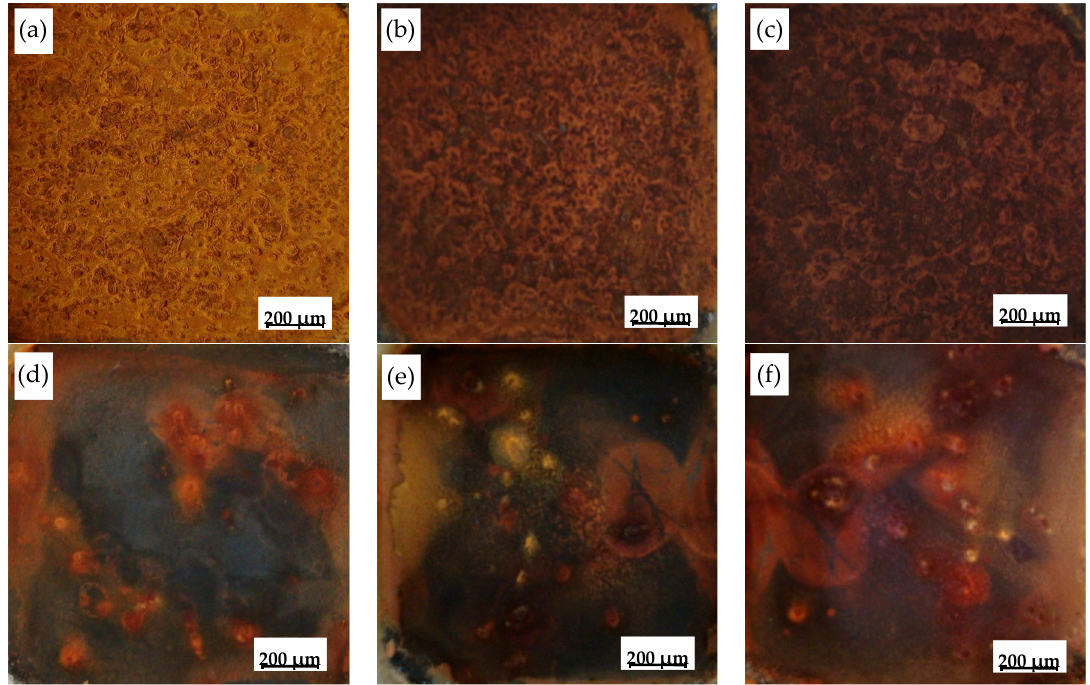
Figure 4. Surface macro-morphologies of type I ( a−c ) and type IV ( d−f ) oxide scale after different corrosion cycles: ( a ) and ( d ) 20 cycles; ( b ) and ( e ) 46 cycles; ( c ) and ( f ) 70 cycles.